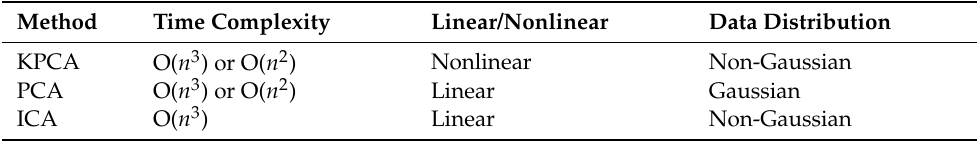
Table 1. Comparison between KPCA, PCA, and ICA.